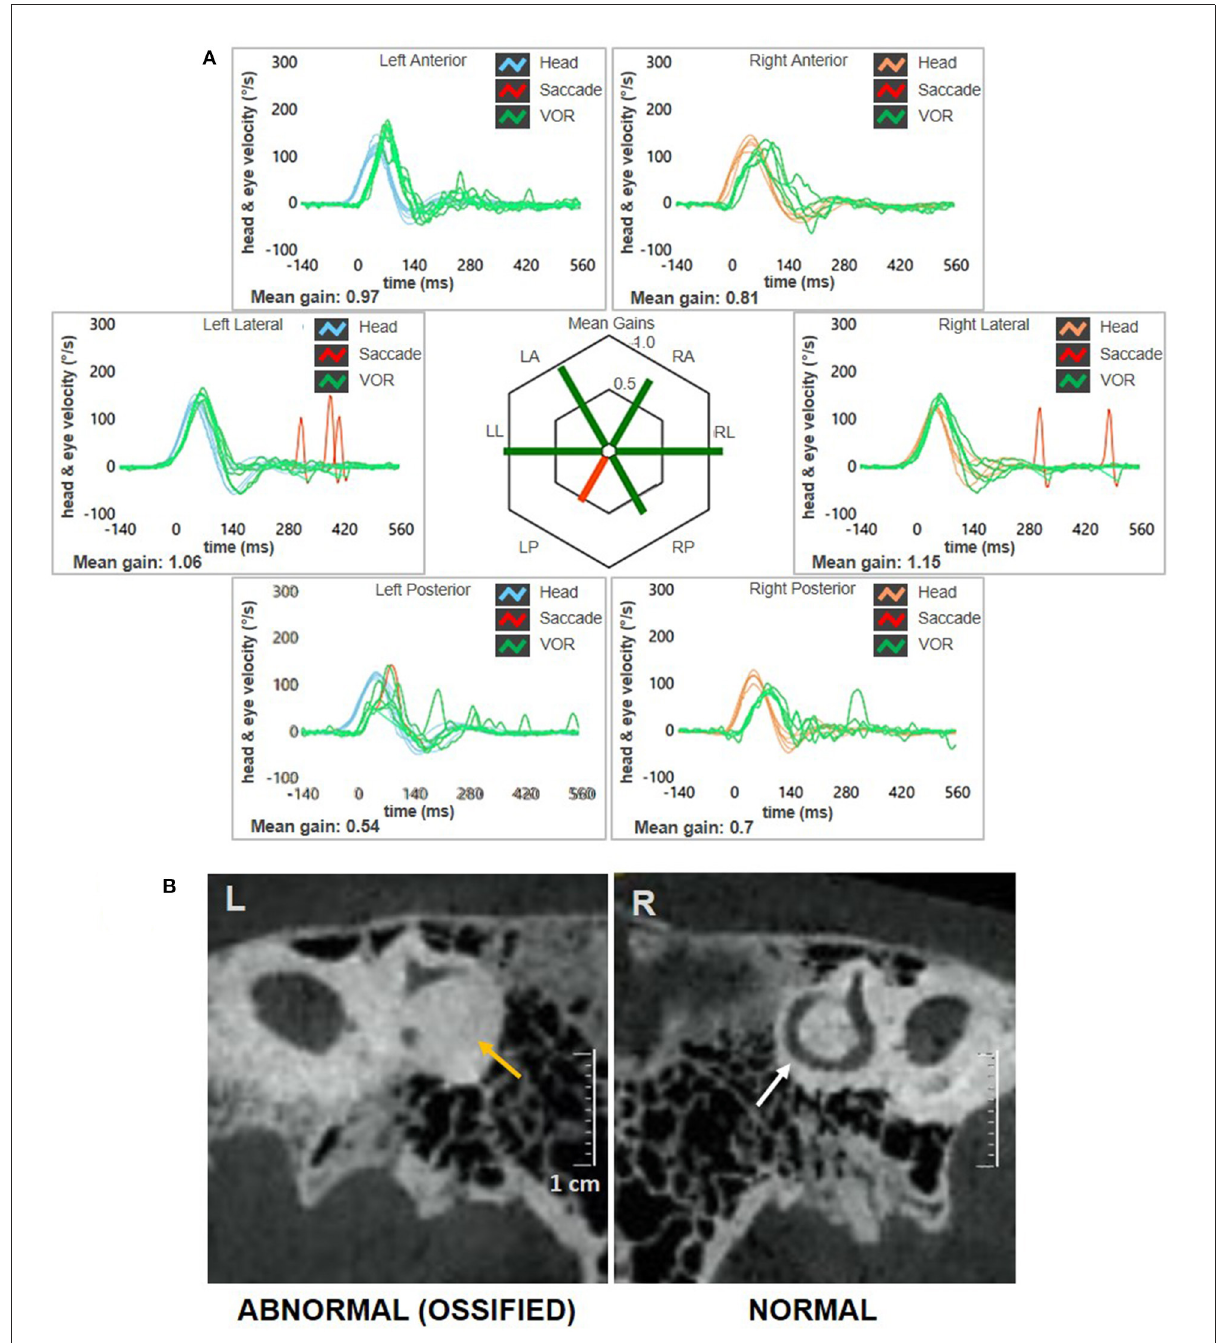
FIGURE3 Instrumental picture observed at 3-months follow-up. (A) Video-HIT exhibited persistent selective loss for the left PSC VOR-gain (0.54) with only covert saccades. The affected canal VOR-gain is slightly increased compared to presenting values. (B) Cone-bream CT scans of the temporal bones with parasagittal reconstructed images along the Stenver plane detecting normally patent right-sided PSC (white arrow) and a near-complete PSC ossification on the left side (yellow arrows). CT, computed tomography; HIT, head impulse test; L, left; LA, left anterior; LL, left lateral; LP, left posterior; PSC, posterior semicircular canal; R, right; RA, right anterior; RL, right lateral; RP, right posterior; VOR, vestibulo-ocular reflex.